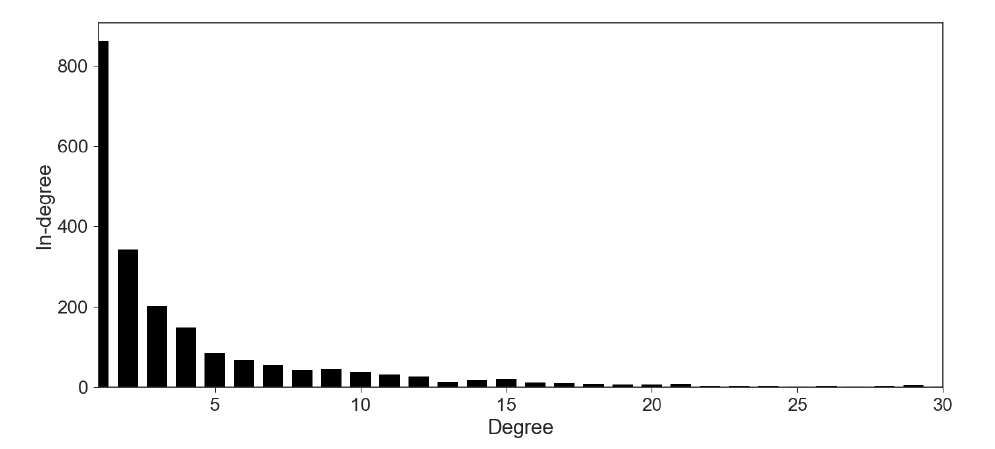
Figure 4. Interbank network in-degree